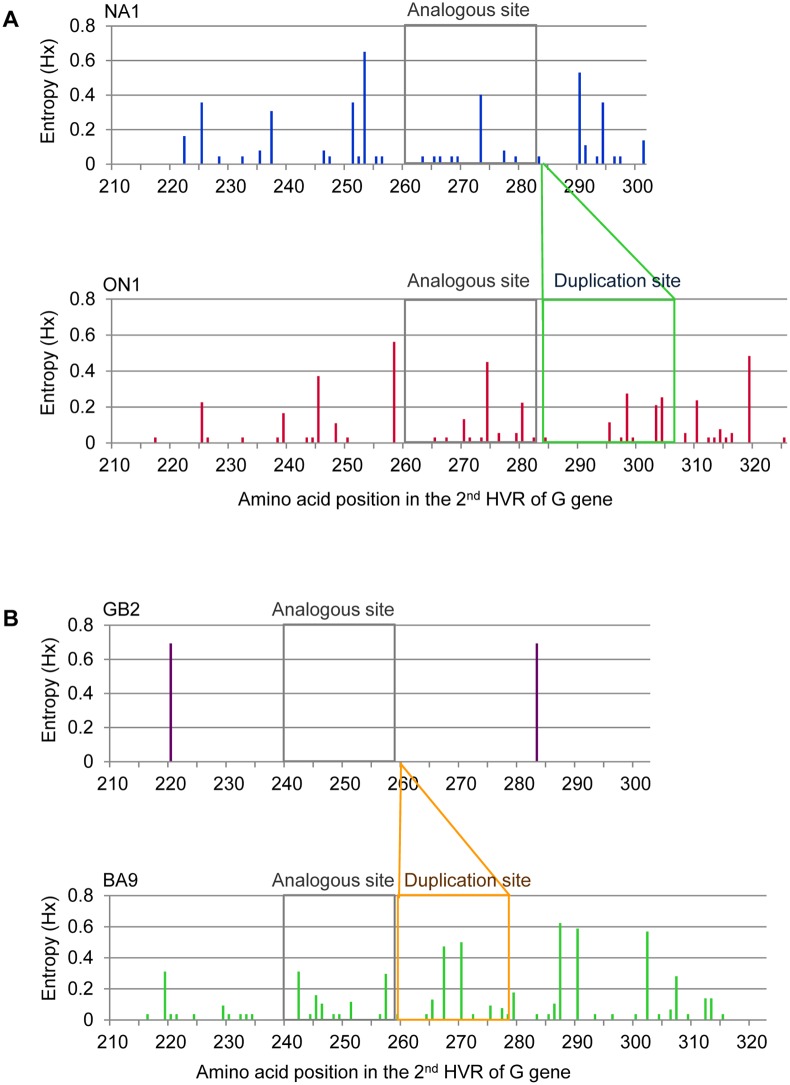
Shannon entropy plots of deduced amino acid sequences of the 2nd HVR of G protein of Philippine strains detected in 2012–2013.Entropy analysis of (A) HRSV-A: NA1 genotype, n = 101 (upper) and ON1 genotype, n = 204 (lower) and (B) HRSV-B: GB2 genotype, n = 2 (upper) and BA9 genotype, n = 116 (lower) in four study sites in the Philippines. The amino acid variability across the second hypervariable region of the G gene is represented by the entropy plot as determined by BioEdit software. The threshold value was set at 0.2. Amino acid sites with entropy values <0.2 are considered conserved and values >0.2 are considered variable.